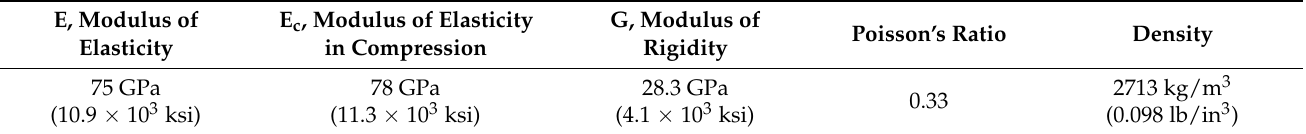
Table 1. Physical properties of wrought (0.5 in-1.5 in thick.) plate Al2050-T84 alloy